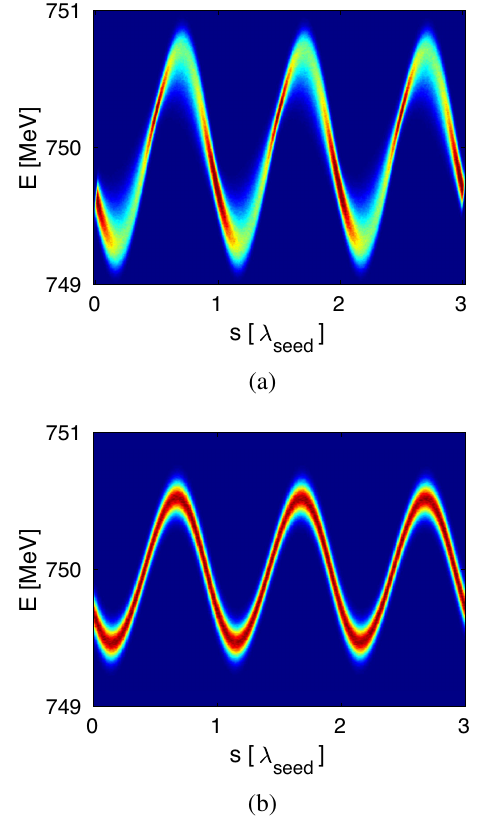
FIG. 3. (a) Longitudinal phase space after modulator 2 in an OK-HGHG setup (see Fig. 2). With an R 56 ; 2 ¼ 51 μ m, we get b ¼ 8% . (b) Longitudinal phase space after modulator in a 10 standard HGHG setup (see Fig. 1). With an R 56 ¼ 67 . 25 μ m, we get b 10 ¼ 8%